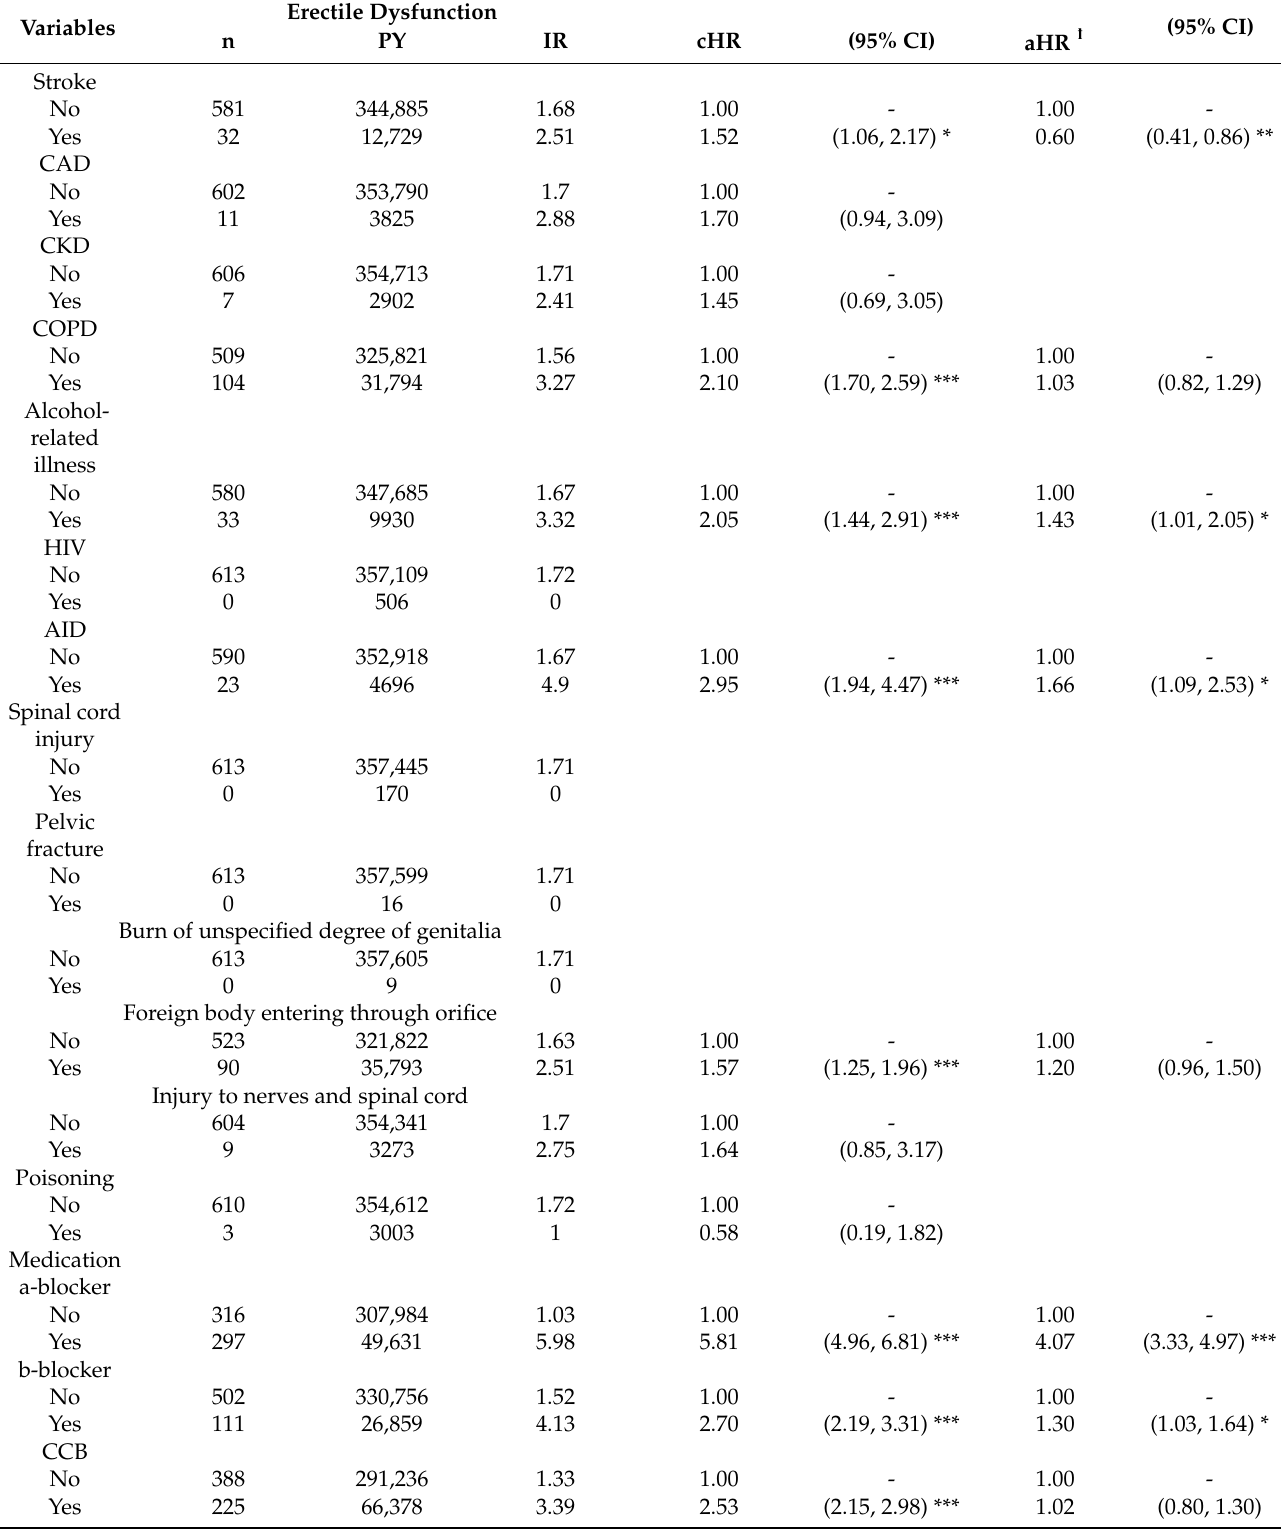
Table 3. Cont. Table 3. The association of explanatory variables and the risk of erectile